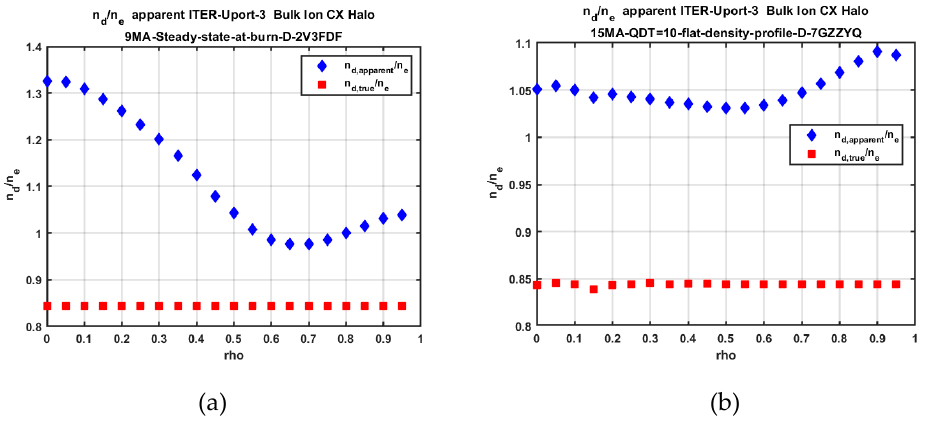
Figure 16. ( a ) Retrieval of plasma dilution n d /n e from from measured D α spectrum. Blue rhombs, apparent values, without correction for halo effect. Red squares, applying halo effect leads to consistent and sensible dilution values <1; ( b ) Retrieval of plasma dilution n d /n e from from measured charge-exchange recombination spectroscopy (CXRS) D α spectrum. Blue rhombs, apparent values, without correction for halo effect. Red squares, applying halo effect leads to consistent and sensible dilution values <1.